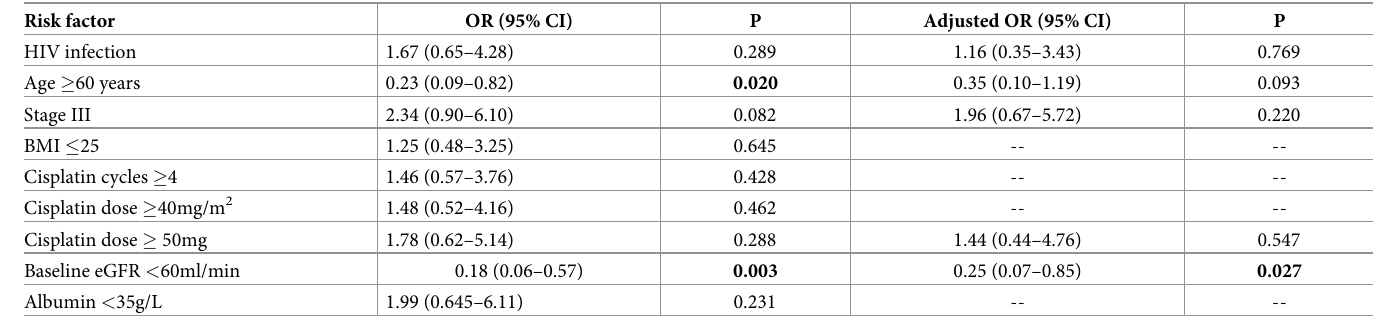
Table 3. Univariate and multivariate logistic regression analysis of potential risk factors for renal